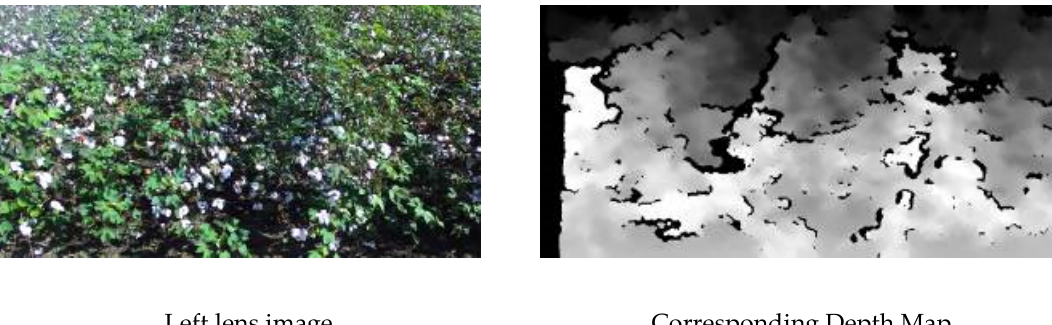
Figure 11. Collected RGB image and corresponding depth map for cotton row detection (0–255, 8-bit greyscale image).